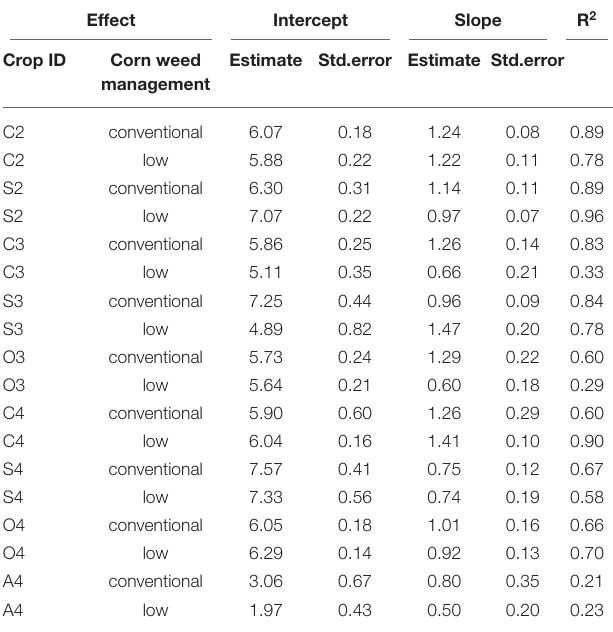
TABLE 8 | ANOVAs for the effects of crop identity, corn weed management, and female aboveground mass on individual female aboveground mass (A) , fecundity (B) , and fecundity with aboveground mass covariate (C) .